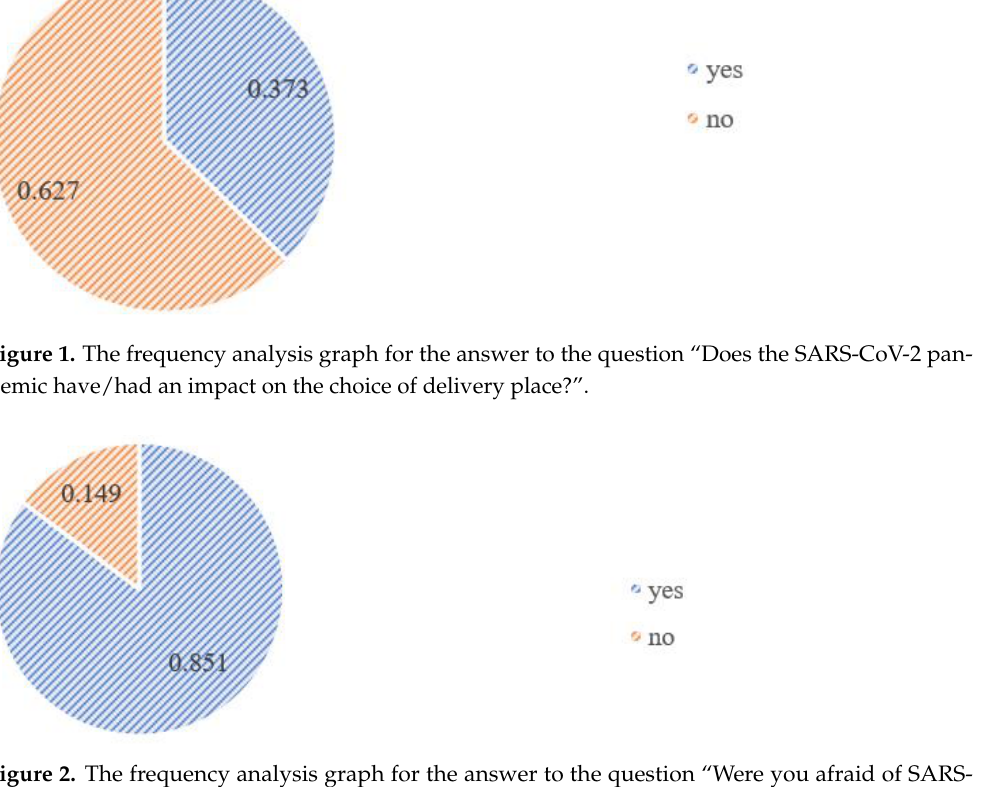
Figure 2. The frequency analysis graph for the answer to the question “Were you afraid of SARS- CoV-2 infection during your pregnancy?”.